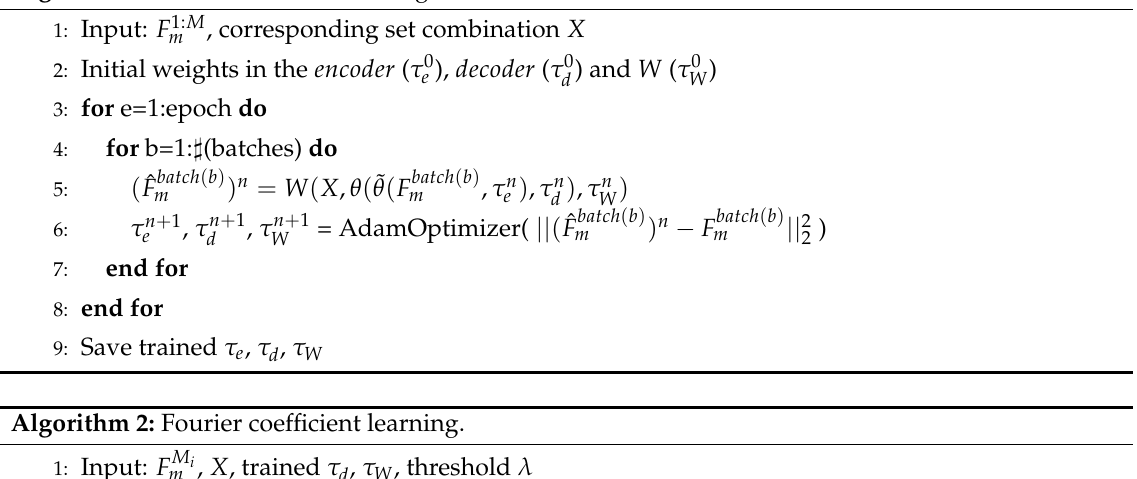
Algorithm 2: Fourier coefficient learning.